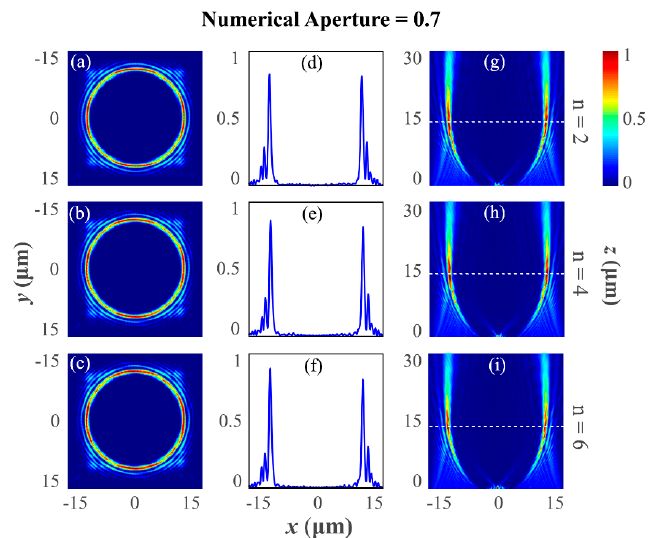
Figure 4. Far-field intensity distribution of the PV beam-generating metasurfaces for numerical ap- erture NA = 0.7 and different topological charges ℓ = 2,4,and 6 . ( a – c ) Transverse intensity distri- bution of the diffracted light at the designed focal plane at ~14 µm (XY-monitor). It is seen that regardless of the value of the topological charge, the ring radius is unaltered, thus verifying the generation of a perfect vortex beam. ( d – f ) indicate the full-width half-maximum of the light at the focal plane. While minting the numerical aperture NA = 0.7 , the focal length of the lens is decided as 2 7⁄ times lower than the actual focal length. ( g – i ) The required longitudinal intensity distribu- tion forms non-diffracting type field behavior and formation of constant ring radius with maximum intensity at the desired focal plane.